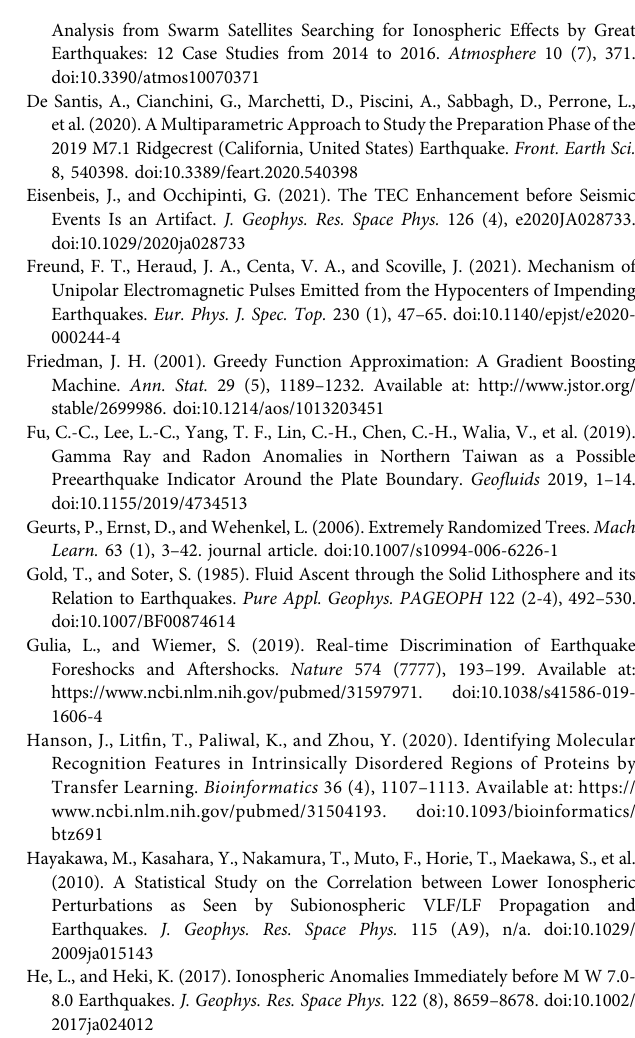
Supplementary Figure S1 | Electron density (Ne) and electron temperature (Te) sequence labels from real cases. Supplementary Figure S2 | Receiver operating characteristic (ROC) curves demonstrating the performance of SeqNetQuake using nighttime data. Supplementary Figure S3 | Ternary probability diagrams showing the results of SeqNetQuake-DT. Supplementary Table S1 | Datasets with different features generated using DEMETER and CSES data. Supplementary Table S2 | Search space of parameters for the SeqNetQuake